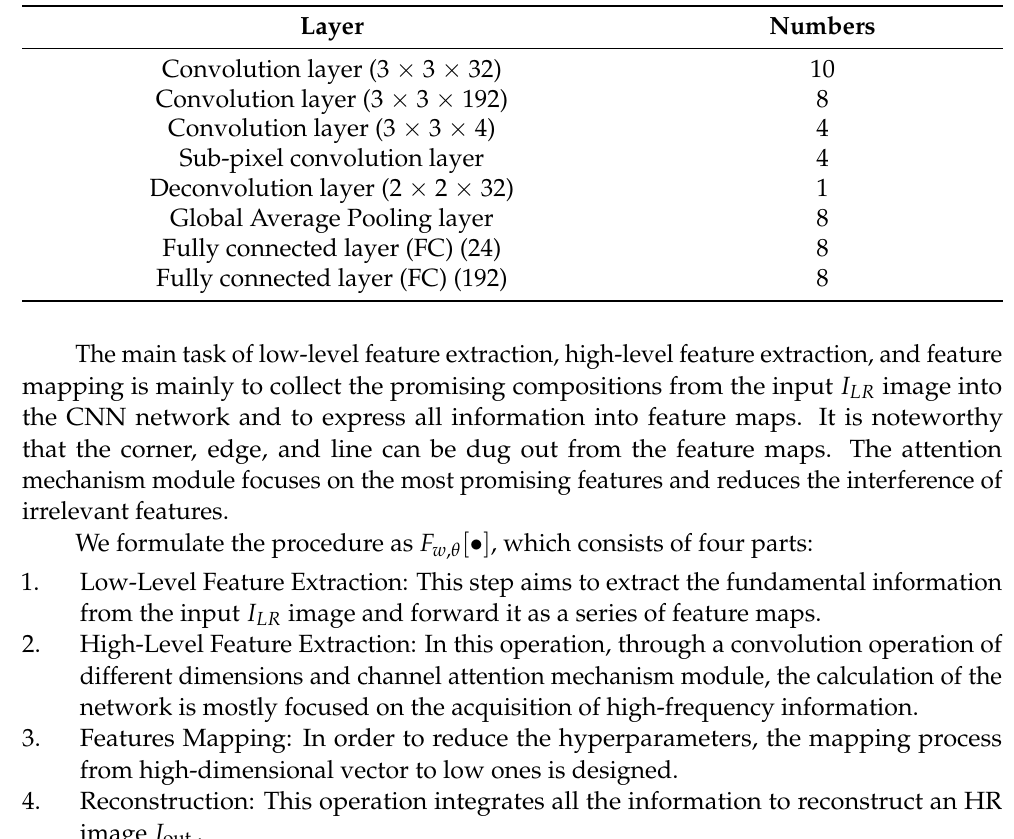
Table 1. The number and parameters of convolution layer in the super-resolution network structure.